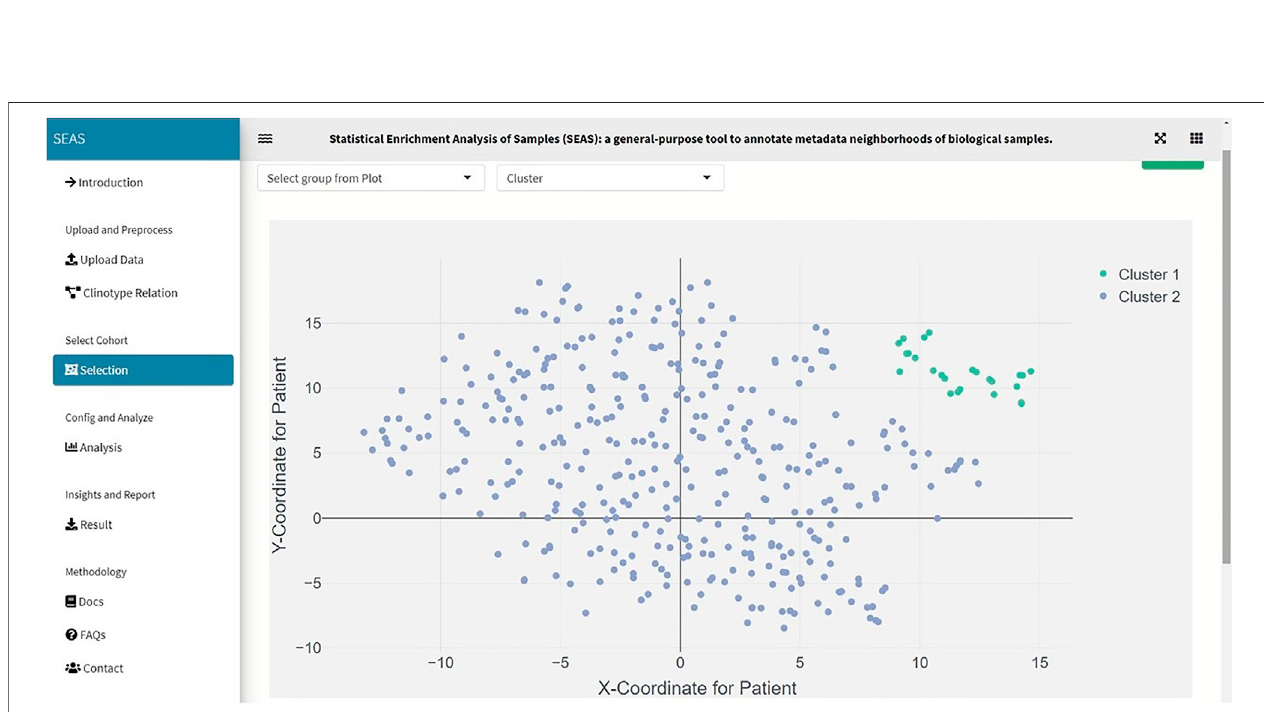
FIGURE 3 | SEAS identi fi es a subcohort by clustering the TCGA-GBM patients (green dots on the top-right of the embedding scatterplot).